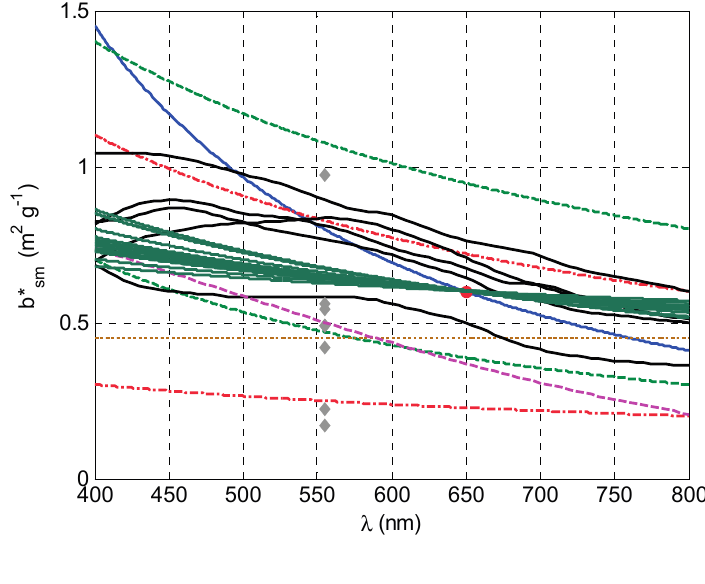
( λ ) retrieved in this work (solid, blue) to other values from Figure 8. Comparison of b* sm literature. Green, dashed: lower and upper limits of values found in Stramski et al. [46]. Red, dot-dashed: lower and upper limits of values found in Wo ź niak et al. [12]. Grey diamonds: values reported by Bowers and Binding [44] at 555 nm. Beige, dotted: Heege [52] for Lake Constance. Pink, dashed: Odermatt et al. [5] for Lake Constance. Solid, black: example values for Hydrolight/Ecolight [19] taken from various authors. ( λ ) = 0.6 m 2 · g − 1 . Red dot: Solid, green: point retrievals of the QAA, after imposing b* sm,QAA predicted value by Equation